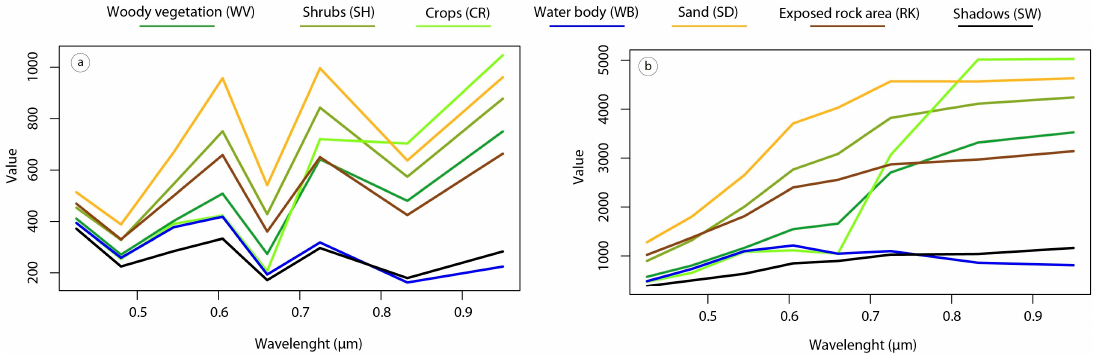
Figure 7. Spectral signatures of the RF classifier, before ( a ) and after ( b ) atmospheric corrections.